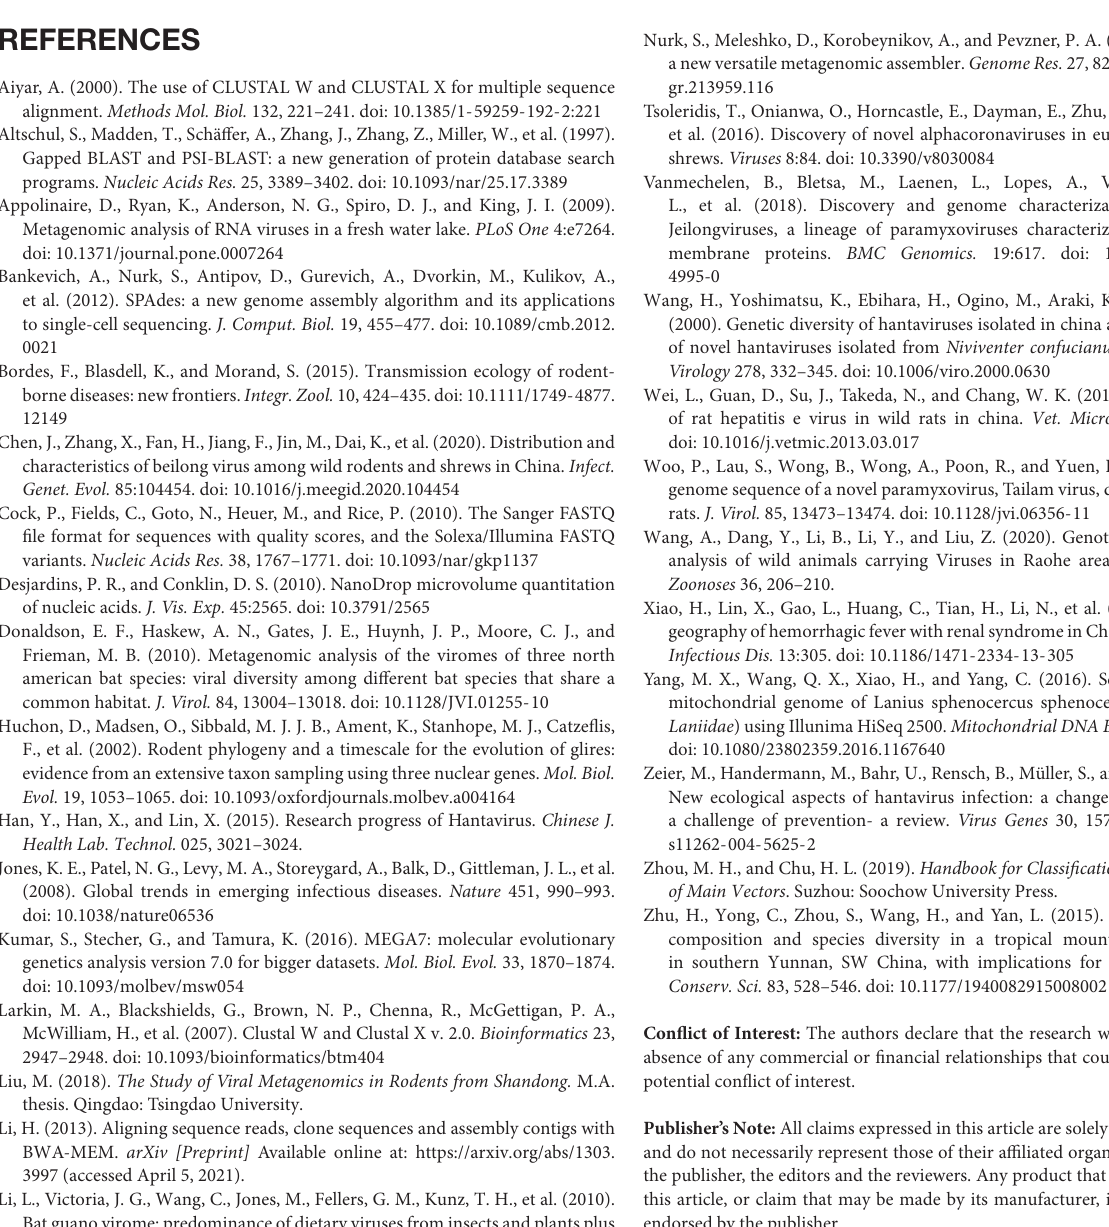
Supplementary Figure 2 | Principal component analysis of rodents in Heilongjiang, Northeast China, and Yunnan, Southwest China. R. flavipectus (YN2), R. flavipectus (YN3), and R. rattus sladeni Anderson (YN5) in Yunnan were close to each other. B. indica (YN4) , R. yunnanensis (YN7) , E. miletus (YN9) , and R. flavipectus (YN10) of Yunnan and M. fortis (RH1) and A. agrarius (RH3) of Raohe County clustered